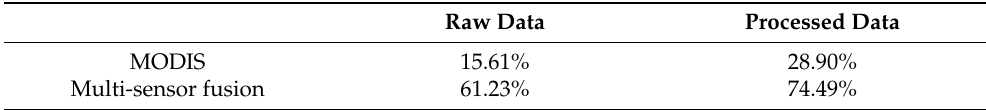
Table 1. On 1 January 2005, the total number of grids with valid data was divided by the total number deeper than 2000 m above the